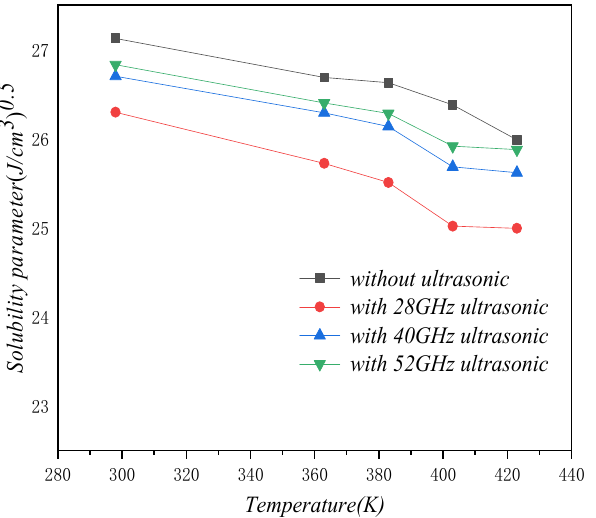
Figure 9. Solubility parameters of nano-silica modified asphalt at four different frequencies and temperatures.